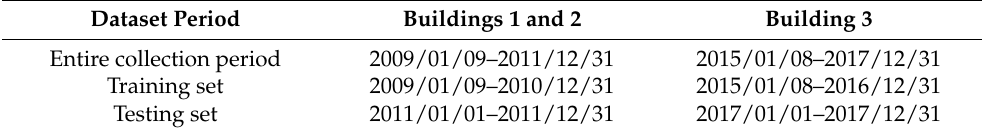
Table 5. Dataset period